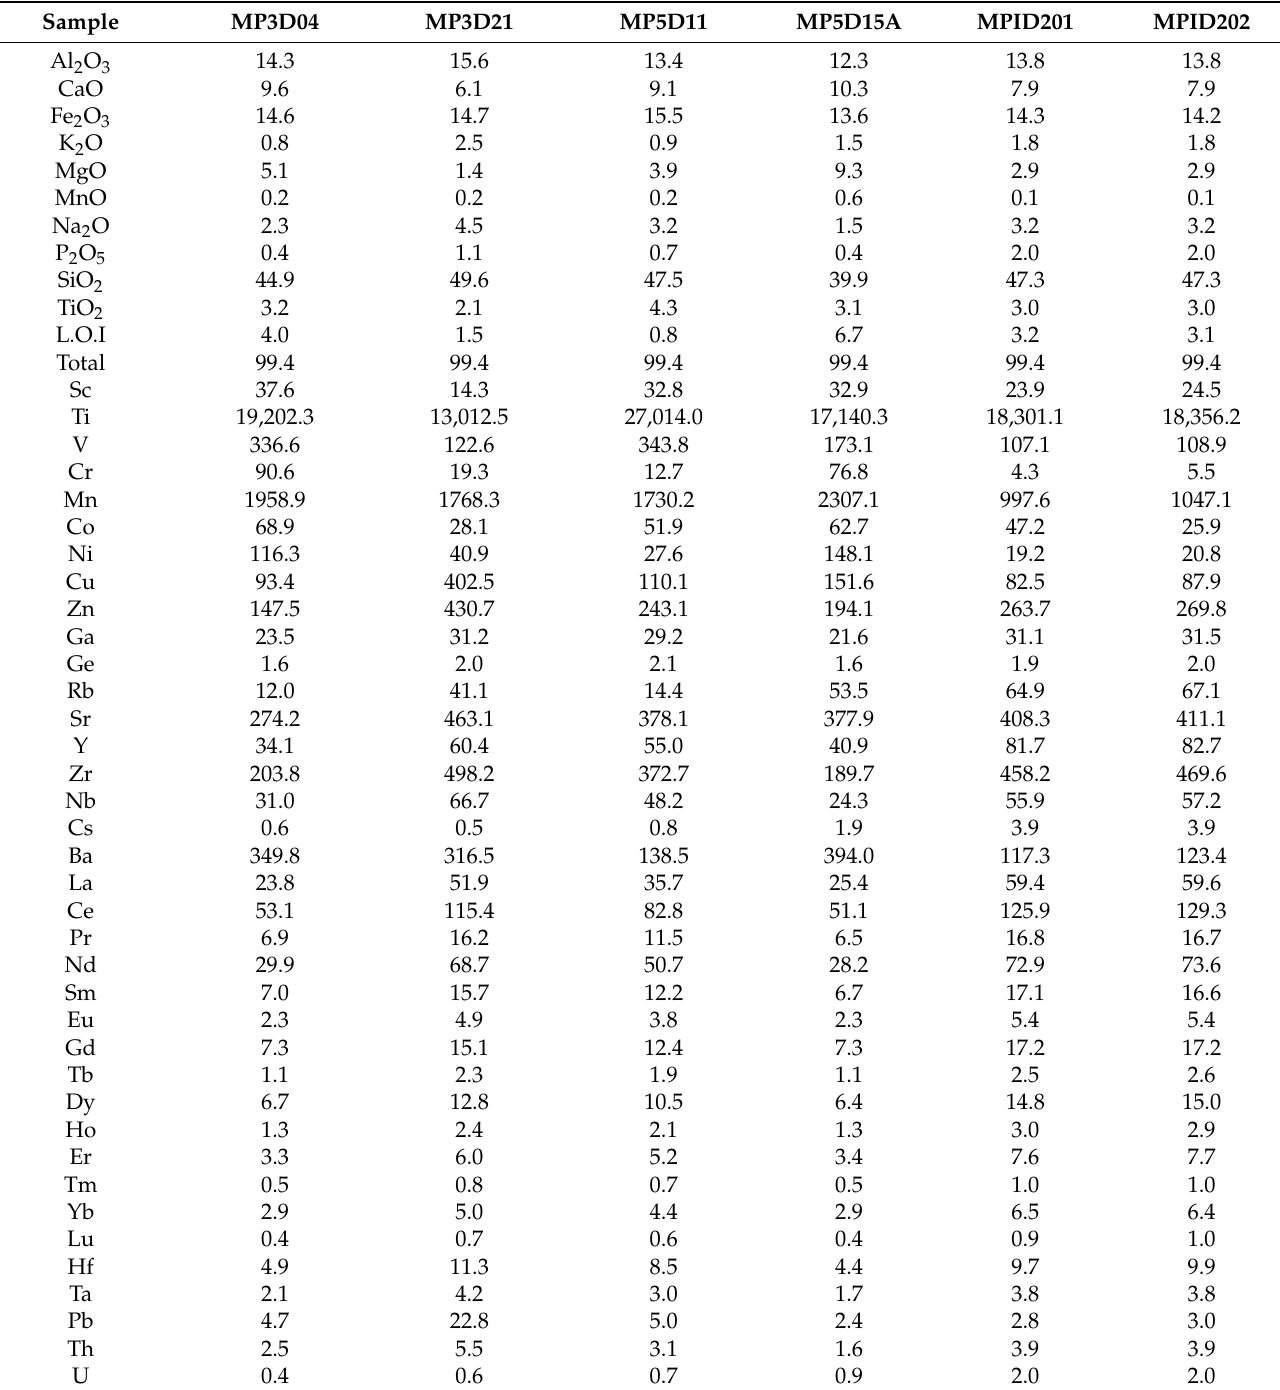
Table 2. Basalt major element (%) and trace element (ppm) concentrations of seamounts in